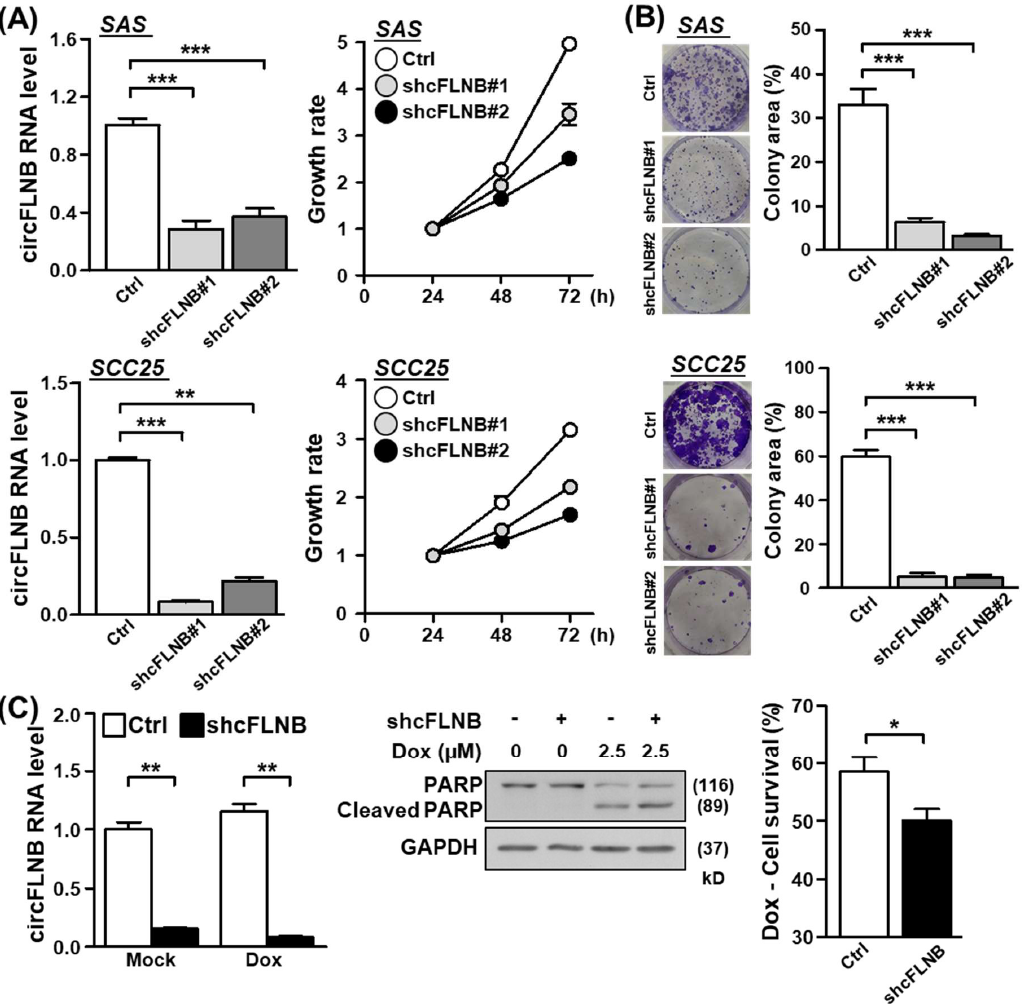
Figure 4. circFLNB is critical for maintaining oral cancer cell growth. The oral cancer lines SAS and SCC25 were subjected to circFLNB knockdown by means of lentiviral infection (shcFLNB#1 and shcFLNB#2), and knockdown efficacy was assessed by qPCR. Cell proliferation rate ( A ) and colony formation ability ( B ) of the knockdown cells were assessed by the MTT method and crystal violet staining, respectively. In ( B ), representative images (left) and quantified results based on colony area (right) are shown. ( C ) Control and circFLNB knockdown cells were treated with doxorubicin to induce apoptosis. PARP protein expression/cleavage (middle) and extent of cell survival (right) of the treated cells were analyzed by Western blot and MTT assays, respectively. GAPDH expression was used as the loading control. For statistical analyses shown in this figure: * p < 0.05; ** p < 0.01; *** p < 0.001.